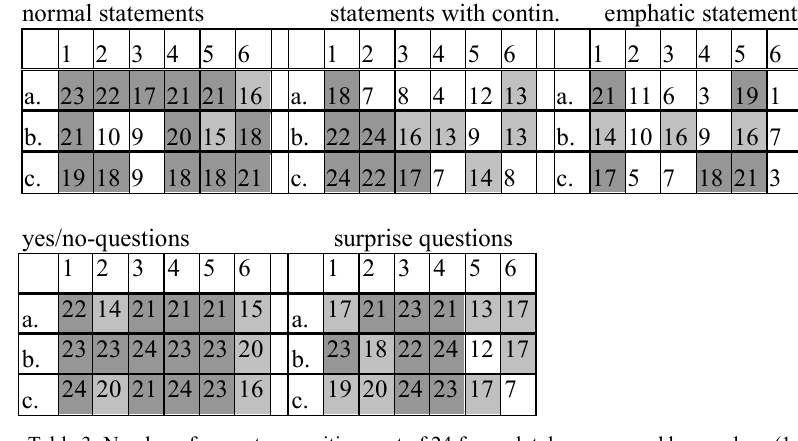
Table 3: Number of correct recognitions out of 24 for each token, arranged by speakers (1– 6) who produced the tokens and by sentence a.–c., corresponding to (1a.–c.) above. Tokens recognized well and particularly well are highlighted (see explanation in the